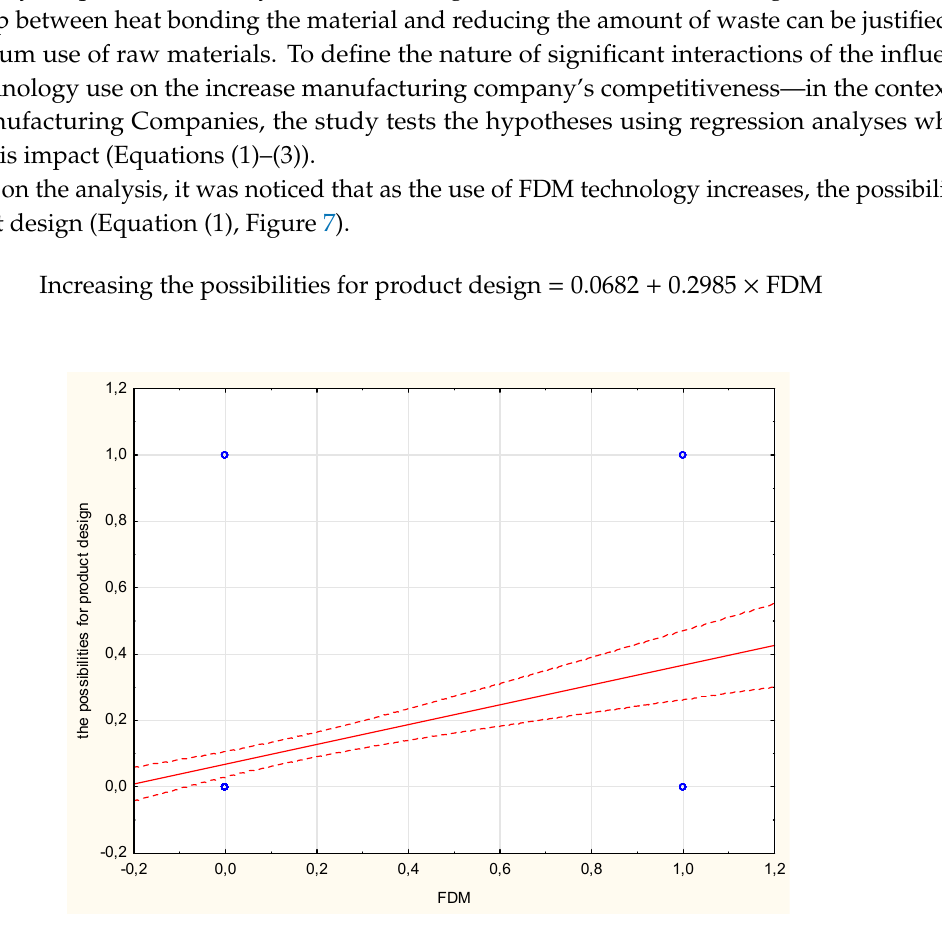
Figure 8. Interactions between the use of heat bonding and the reduction of post-production waste. The results obtained showed that with the increase in the use of laser cutting technology, the level of company development increases significantly (Equation (3), Figure 9). development = 0.1074 + 0.6426 × laser cutting